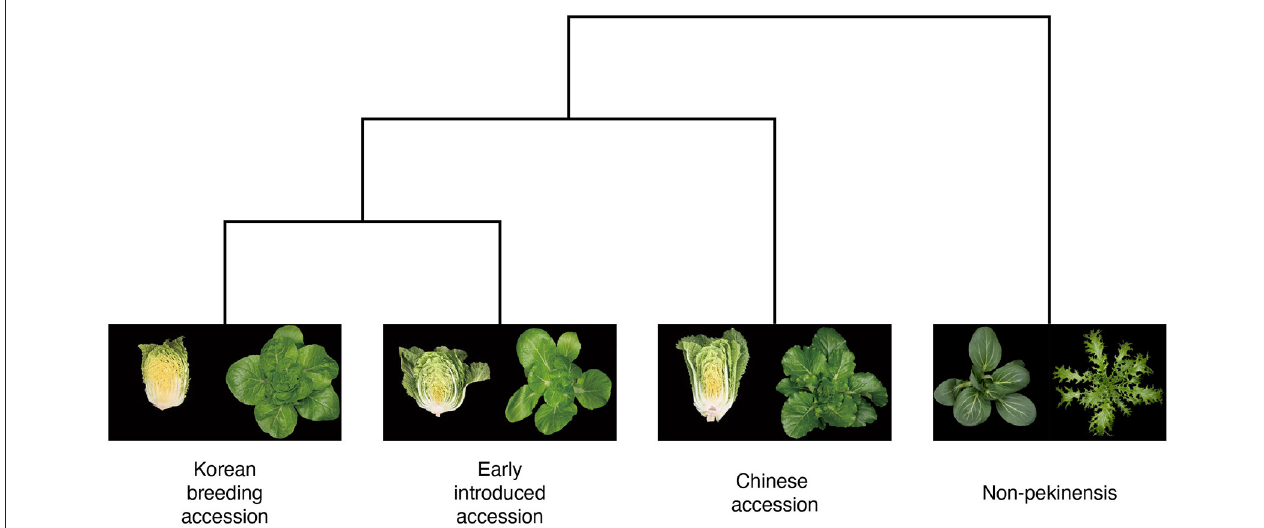
FIGURE 1 | Phylogenetic tree of Brassica rapa with phenotypic images. The phylogenetic tree shows breeding history of four different groups (Korean breeding accession, early introduced accession, Chinese accession, and non-pekinensis) from Chinese cabbage in the east Asia (Ramchiary et al., 2011). Image data were generated from top (four groups) and lateral views (three groups) of plants from the B. rapa core collections. The trait of forming leafy head is the main factor to distinguish subspecies pekinensis